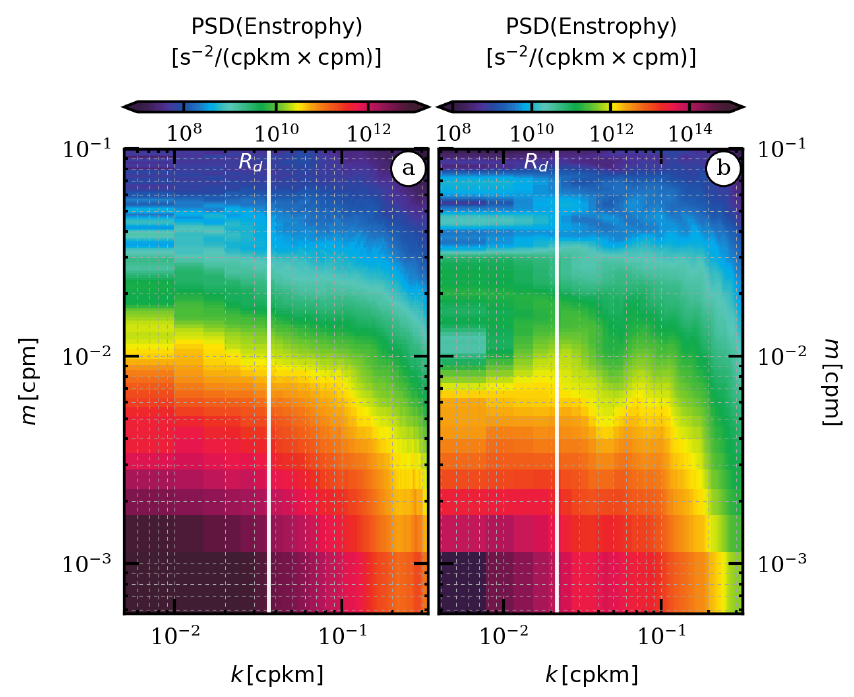
Figure 9. Power Spectrum Densities (PSDs) of enstrophy computed ( a ) in the Gulf of Oman, and ( b ) in the Gulf of Aden. The deformation radius is indicated in vertical solid white